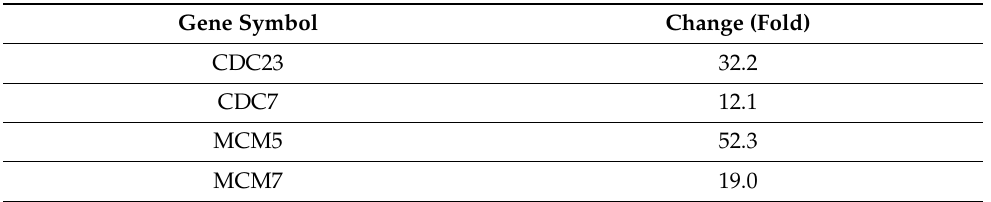
Figure 8. Effect of MOPs on tooth movement (ref. 132). * Significantly different from corresponding the tooth movement (TM) group and the TM+MOPs group ( p < 0.05). Values are shown as the mean ± SD of 5 rats. Table 4. DNA Chip analysis for MOPs during rat experimental tooth movement. Increasing minichromosome maintenance (MCM) and cell division cycle (CDC) gene expressions by MOPs [132].